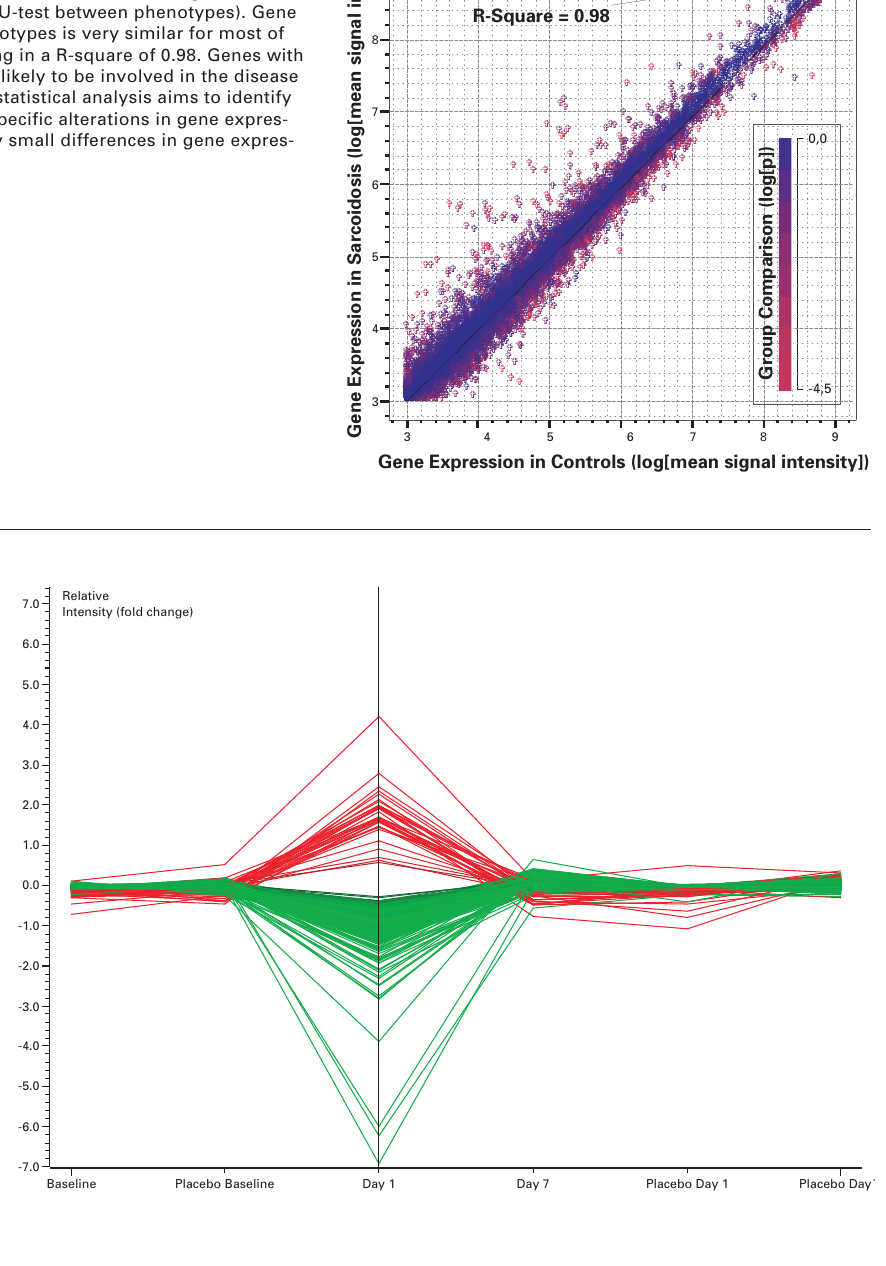
Figure 2 Scatter plot of the mean gene expression in sarcoidosis pa- tients compared to controls. Colour-codes are given for the p-value (Mann-Whitney U-test between phenotypes). Gene expression in both phenotypes is very similar for most of the genes tested resulting in a R-square of 0.98. Genes with different expression are likely to be involved in the disease process. Therefore, the statistical analysis aims to identify genes with phenotype-specific alterations in gene expres- sion within the relatively small differences in gene expres- sion observed.